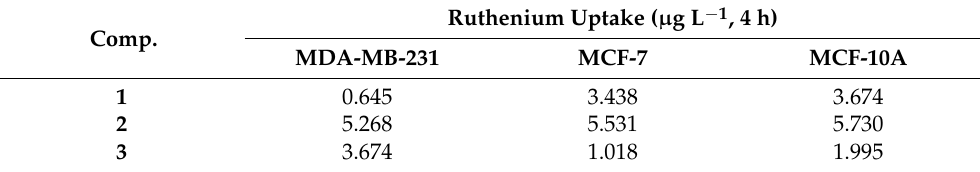
Table 2. Comparison of intracellular accumulation of ruthenium after treatment with complexes 1 , 2 and 3 .